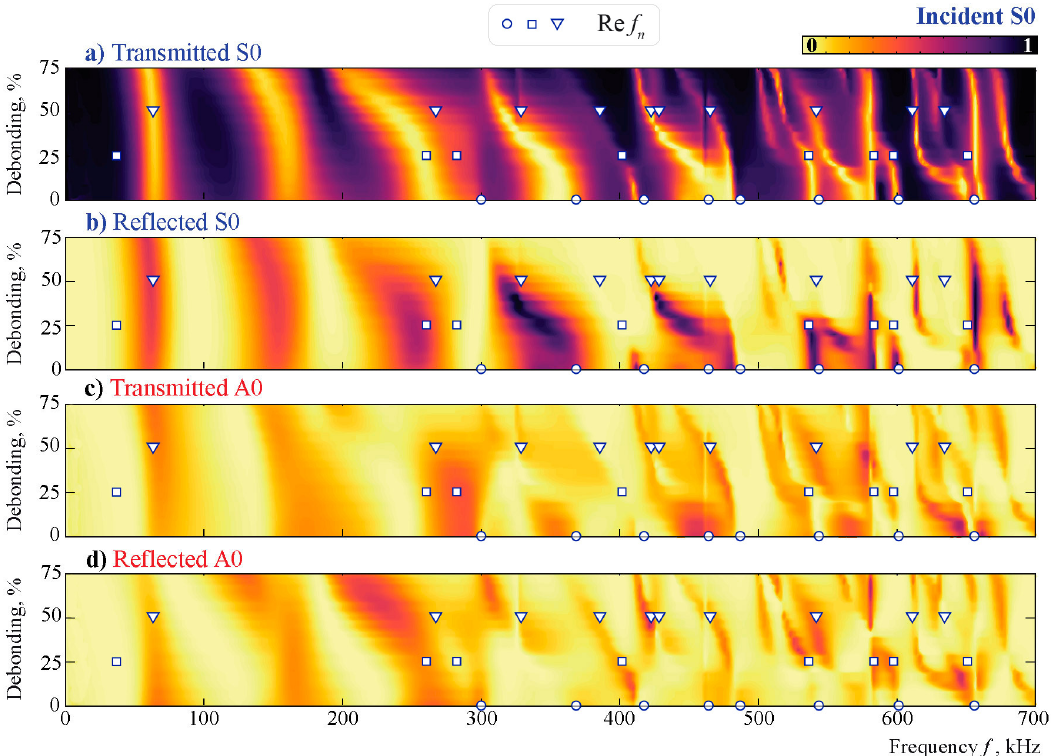
Figure 11. The transmission and reflection coefficients β ± m ( f , a ) for the incident S0 mode scattered by a debonded obstacle and the eigenfrequencies calculated for three different debonding states.